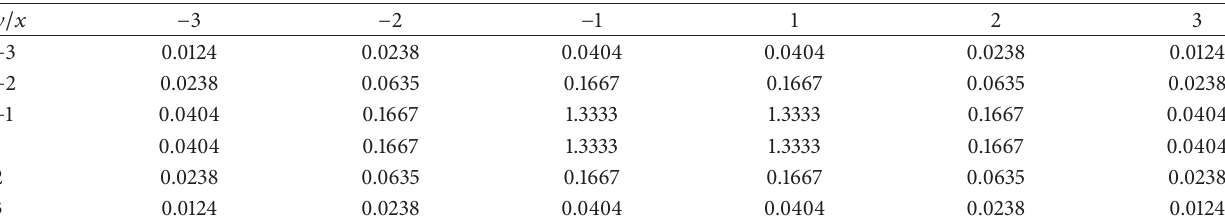
Table 6: Positive surface data from function 𝐹 4 (𝑥,𝑦)